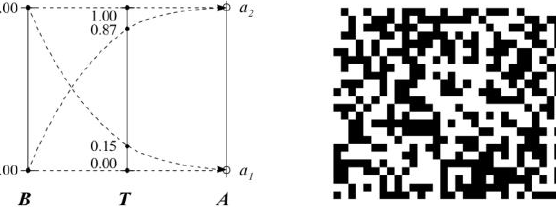
Figure 5. Bias ambiguity. Left: diagram of rule set f 2 , with arrows linking the intensities that are used. Middle, left: the random bias image from an image sequence generated by rule set f 2 . Middle, right: the slightly distorted trigger image. Right: the target afterimage pattern, with a 1 and a 2 shown as before.